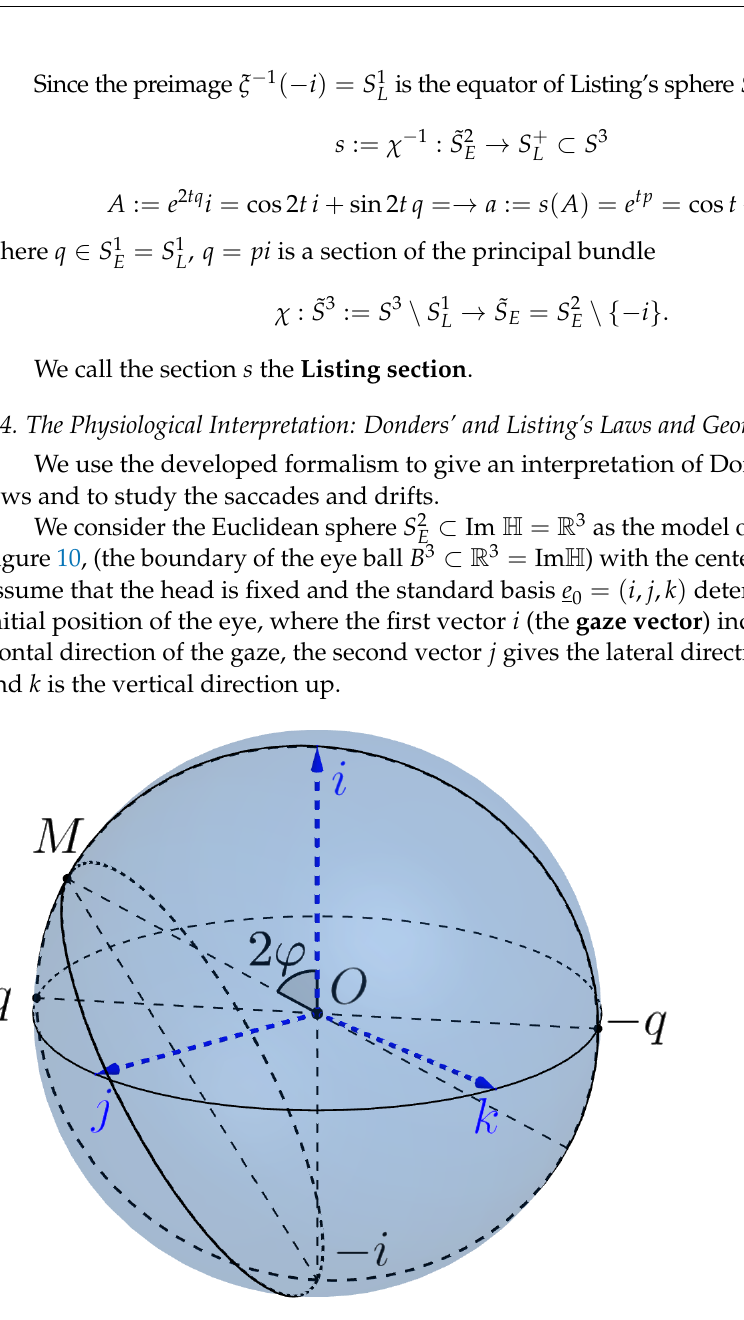
Figure 10. The eye